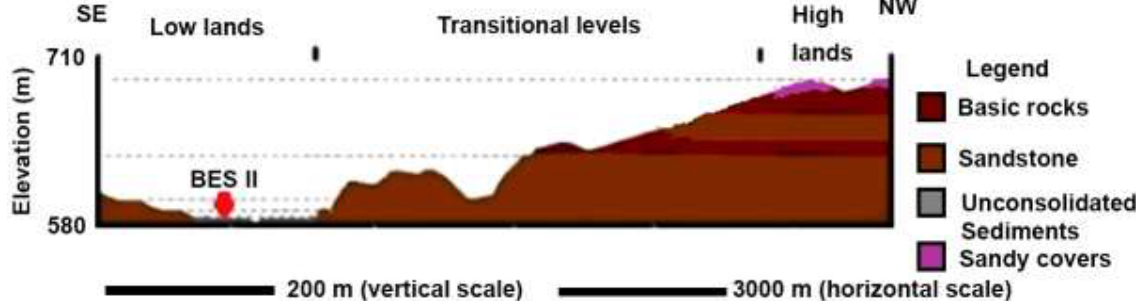
Figure 3. Morphological-geological profile illustrating summary features and layout of the relief picture and main lithological units. Source: adapted from Cheliz